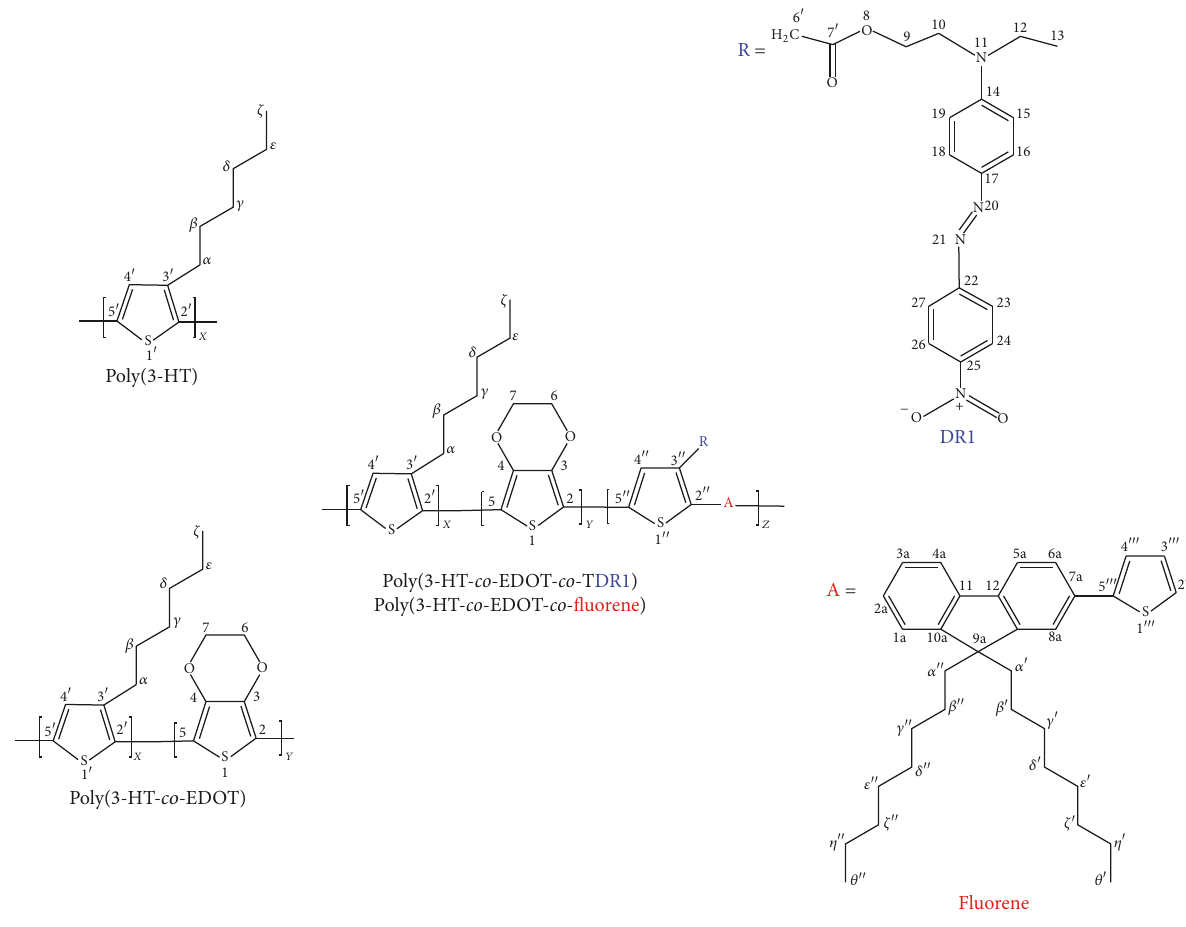
Figure 1: Structures of the